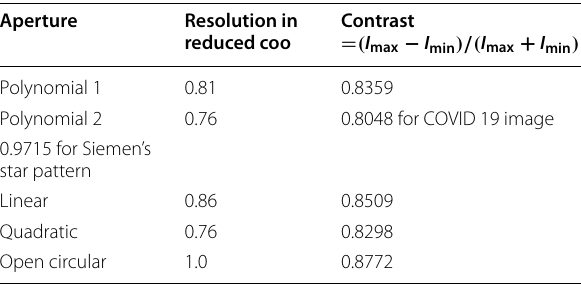
Table 2 Resolution and contrast results for the reconstructed images for different